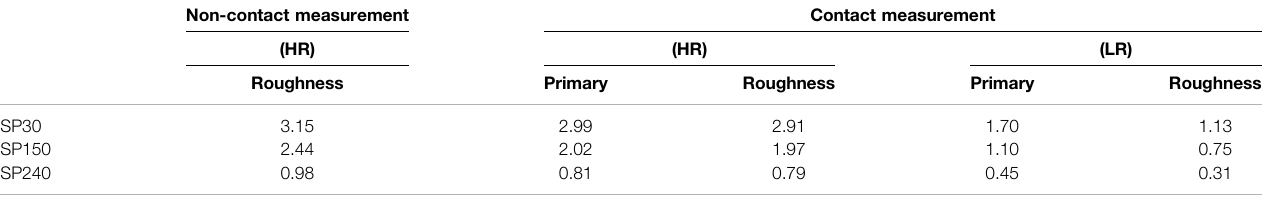
TABLE4| SurfaceroughnessparameterSa[µm]measuredusingcontactandnon-contactpro fi lometersandprocessedaccordingtotheproceduredescribedinSectionof non-contact pro fi lometry. Non-contact measurement